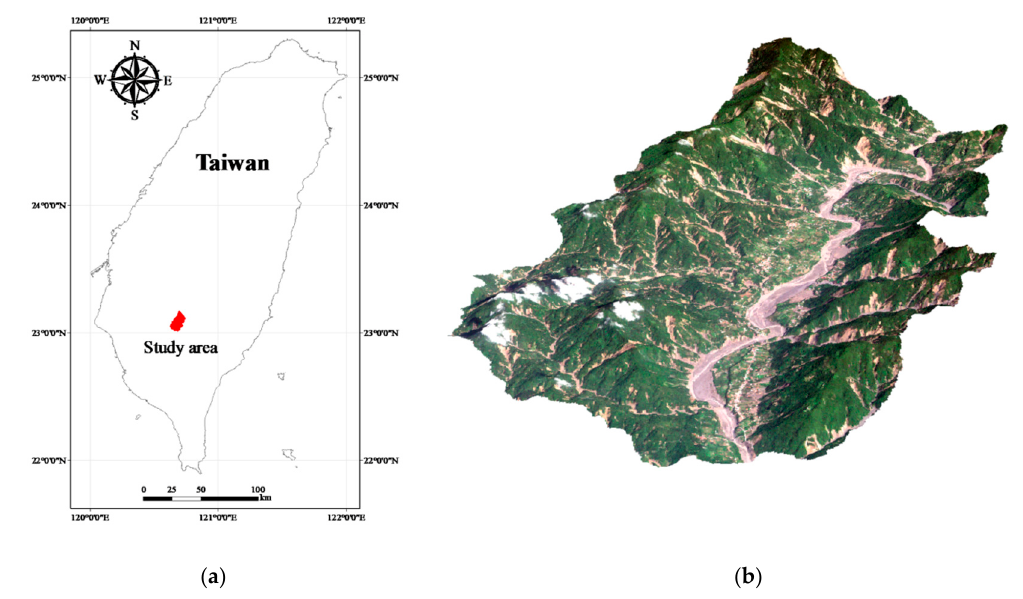
Figure 1. Study area: ( a ) Location, ( b ) 3D view from the south.